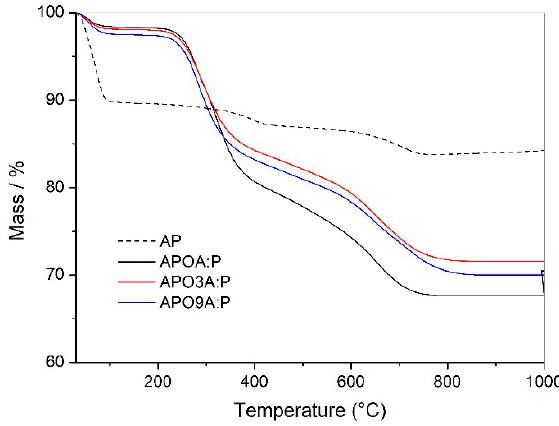
Figure 3. Thermogravimetric analyses (TG) curves of the purified clay (AP) and organically modified purified clay with a mixture of surfactants A-P containing different amounts of A and P. Table 1. Weight loss of the clay AP and of the modified AP with a mixture of the surfactant A-P. Samples T H ( ◦ 2 O